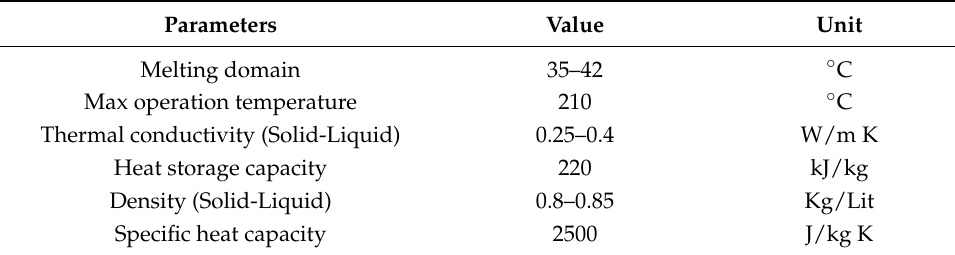
Table 2. The main features of the PCM are adapted from [17].